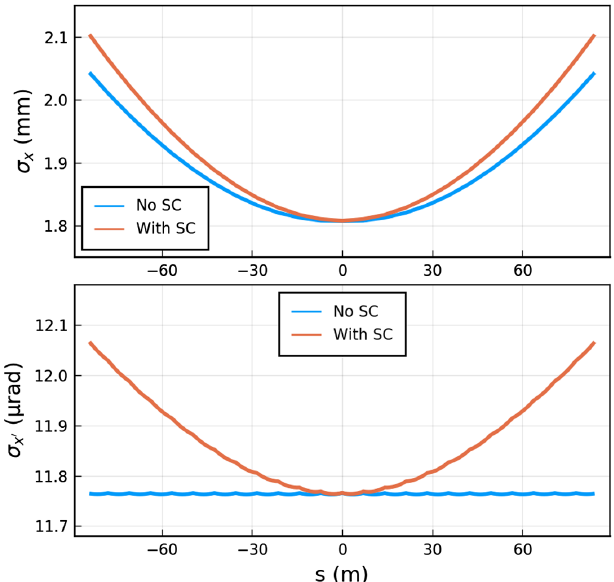
FIG. 11. The evolution of the hadron beam emittance during cooling (upper plot: D i ¼ 0 m , D e ¼ 0 m; bottom plot: D 2 . 5 m, D 2 i ¼ e ¼